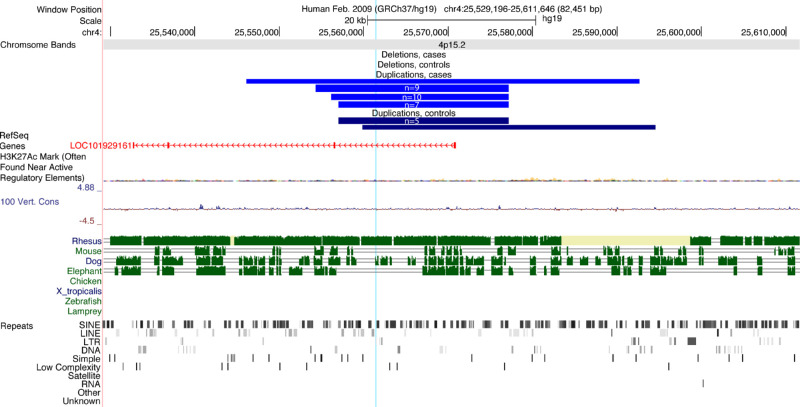
Chromosome 4 duplication significantly enriched in esotropia cases. UCSC genome browser plot showing the region of duplication on 4p15.2 (4:25554332-25577184). Duplications across this region were present in 27 cases (light blue, n indicates number with each set of breakpoints) and six controls (dark blue). The duplication includes exon 1 of LOC101929, a long noncoding RNA (orange). H3K27Ac marks show no putative regulatory regions within the duplication. This area is well conserved with monkeys, but not other mammals. There is no conservation with nonmammals. The blue vertical line indicates the position of the ddPCR probe used to confirm the duplication. At bottom are indicated repeats in the region identified by RepeatMasker: SINE, short interspersed nuclear elements; LINE, long interspersed nuclear elements; LTR, long terminal repeat elements; DNA, DNA repeat elements; SIMPLE, microsatellites, low complexity repeats, satellite repeats, RNA repeats, and other repeats.